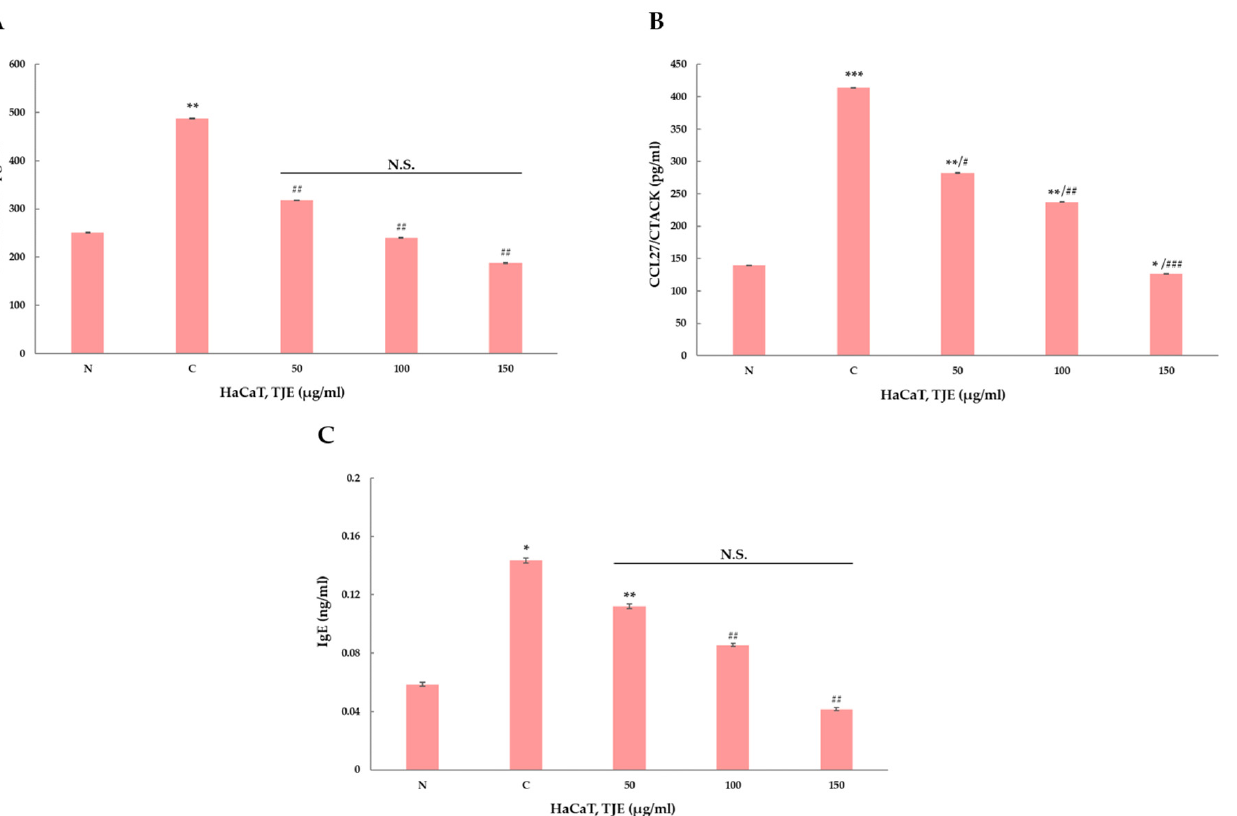
Figure 4. ( A – C ) Measurement of TARC, CTACK, and IgE through ELISA assay. TJE regulated TARC, CTACK, and IgE in HaCaT Keratinocytes. The statistical analysis of the data was carried out by use of a t -test. * ,# p < 0.05, ** ,## p < 0.01 and *** ,### p < 0.001 (each experiment, n = 3). N.S.: not signif- group).